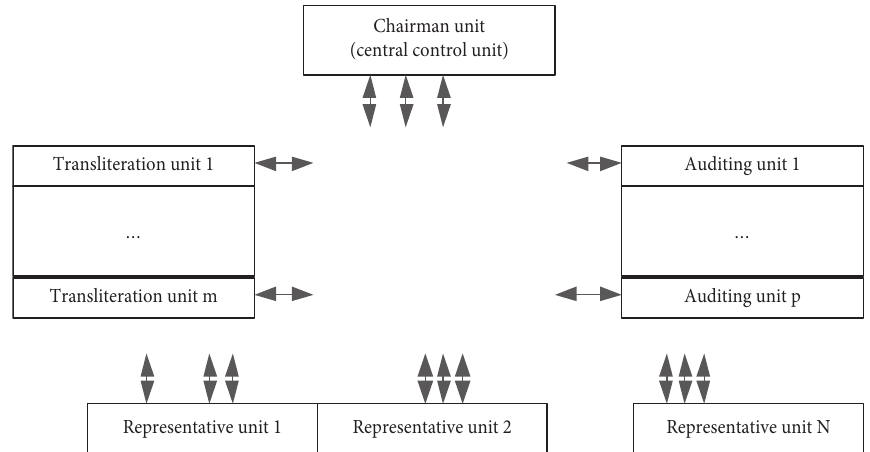
Figure 1: Overall hardware design